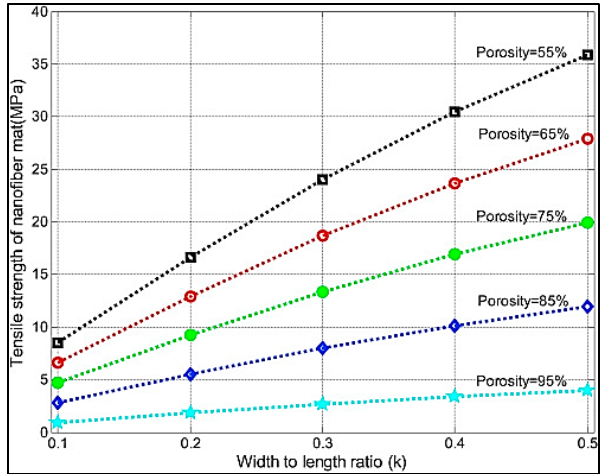
Figure 13. Tensile strength as a function of porosity [1].